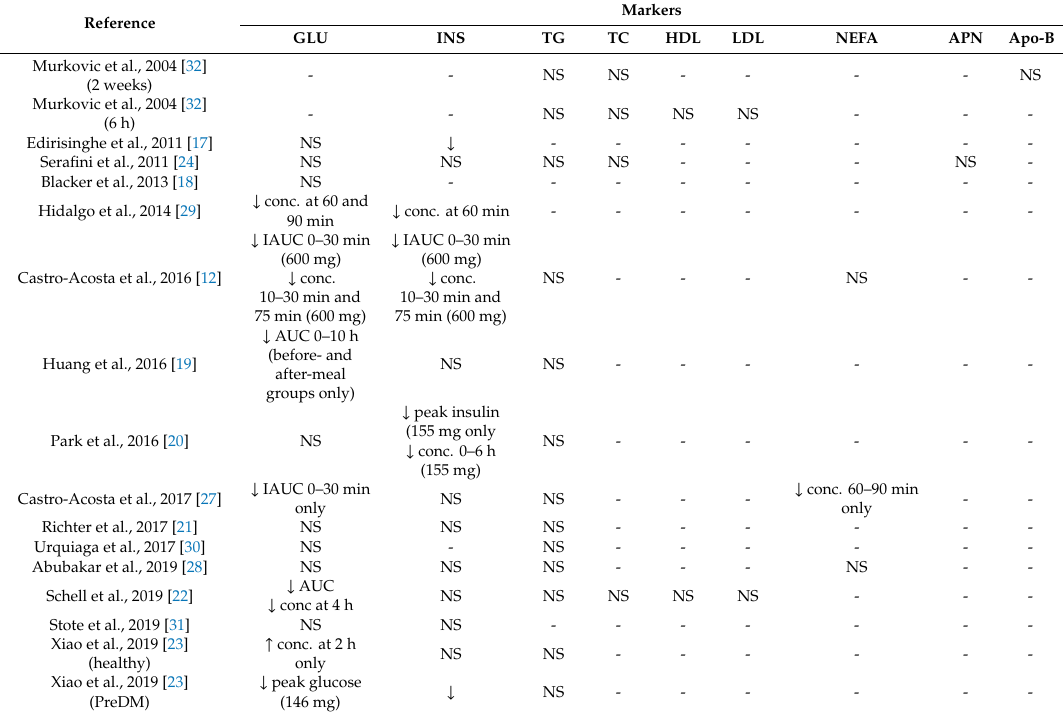
Table 3. E ff ects of anthocyanin intake in composite meals on markers of energy